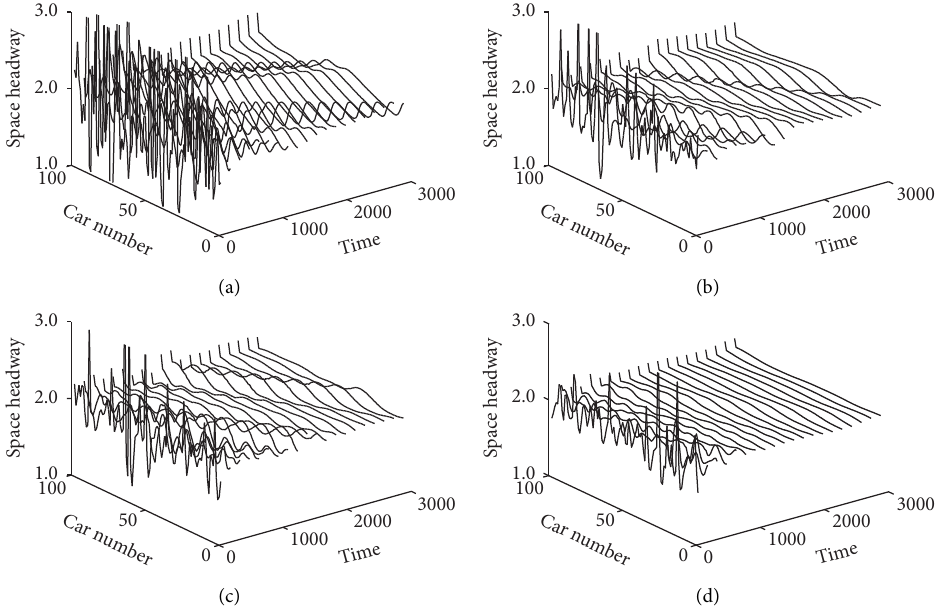
Figure 4: Temporal and spatial space headway when t